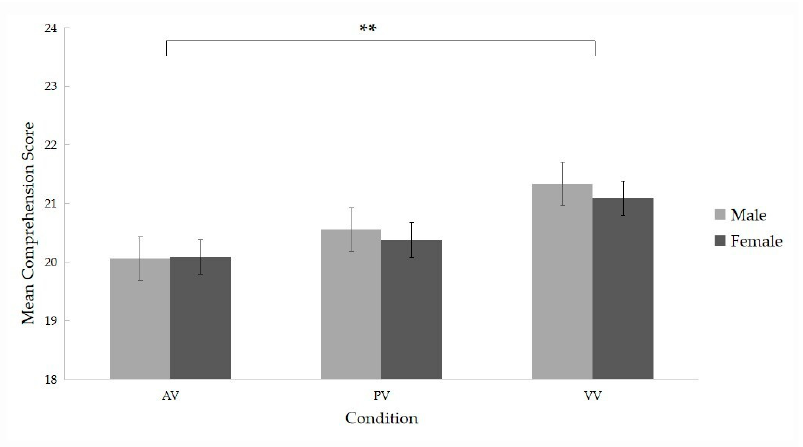
Figure 2. Leaning performance of male and female learners in three instructor conditions. AV, the audio-video condition; PV, the picture-video condition; VV, the video-video condition. ** p < 0.01.